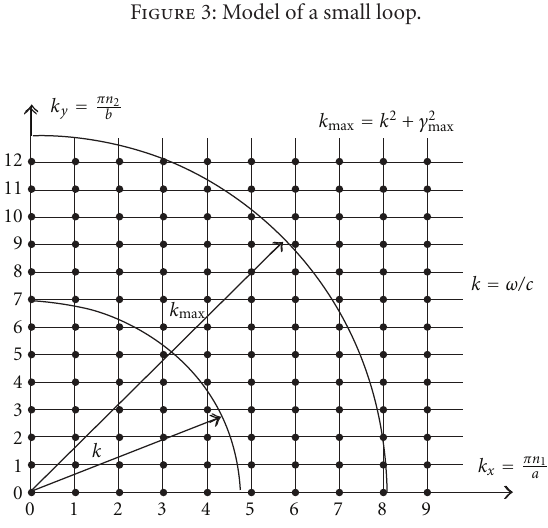
Figure 4: Division of the summation